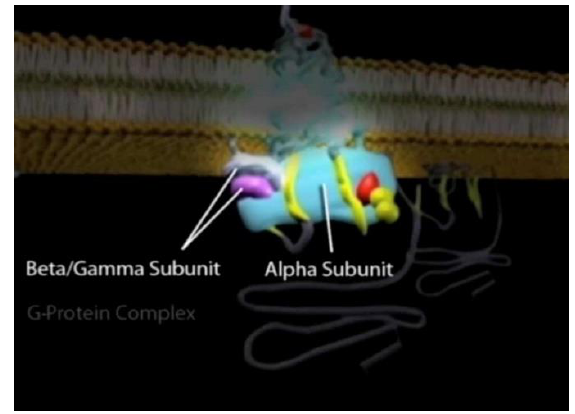
Figure 1. Screenshot of the media showing components of the alpha receptor pathway.